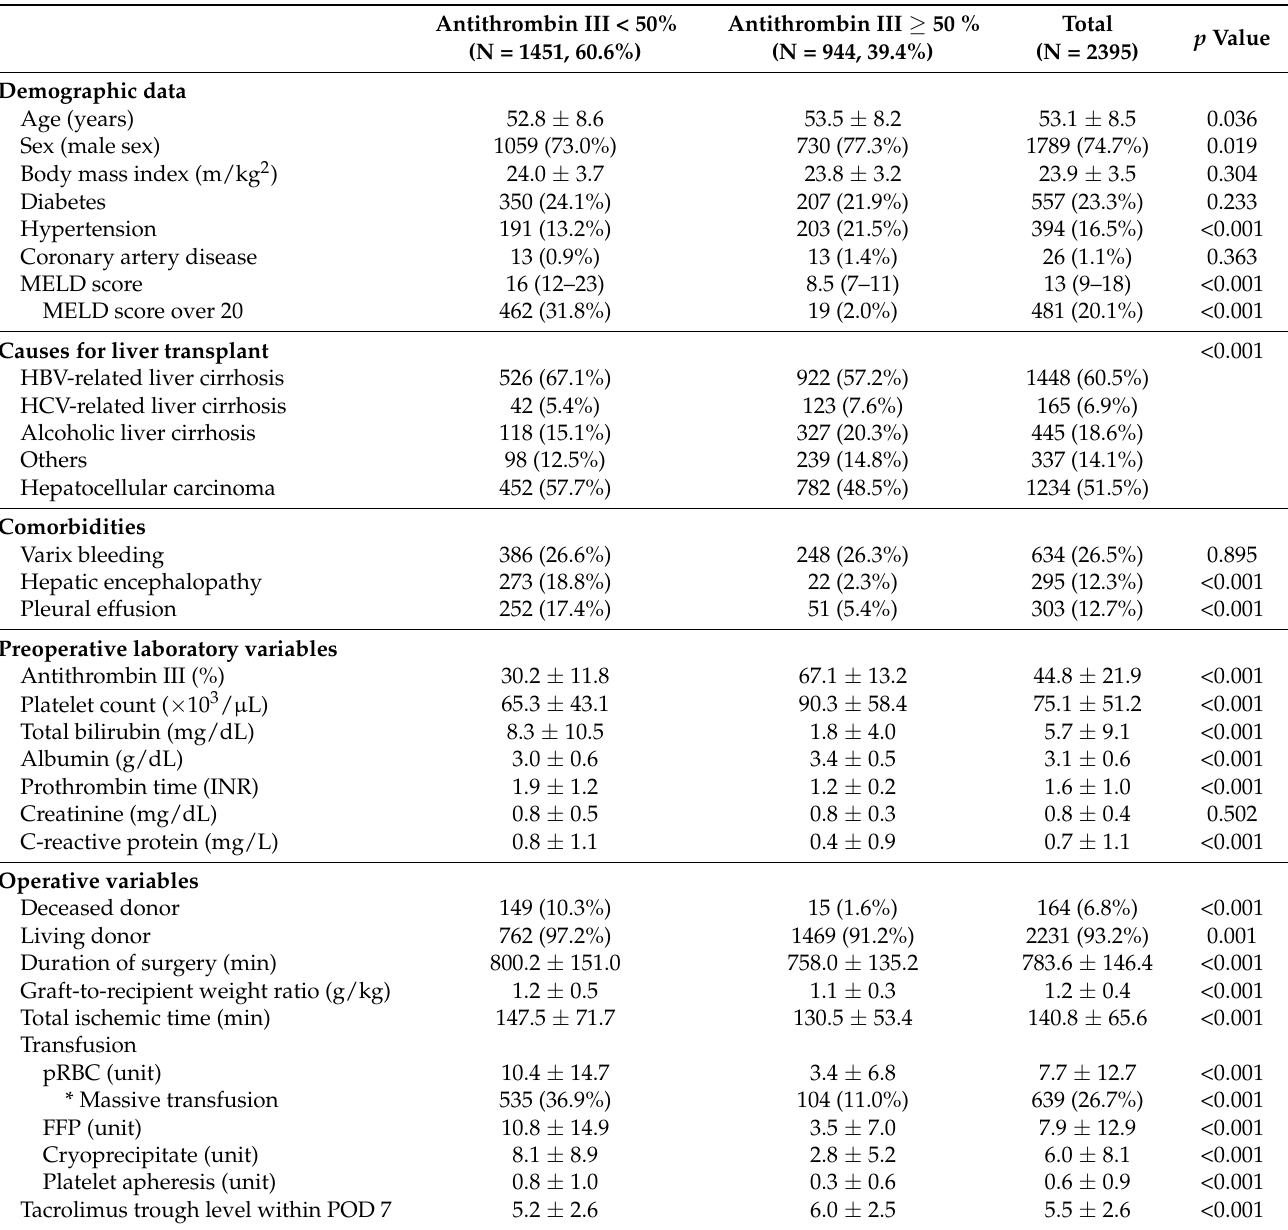
Table 1. Patients’ demographics according to the preoperative antithrombin III